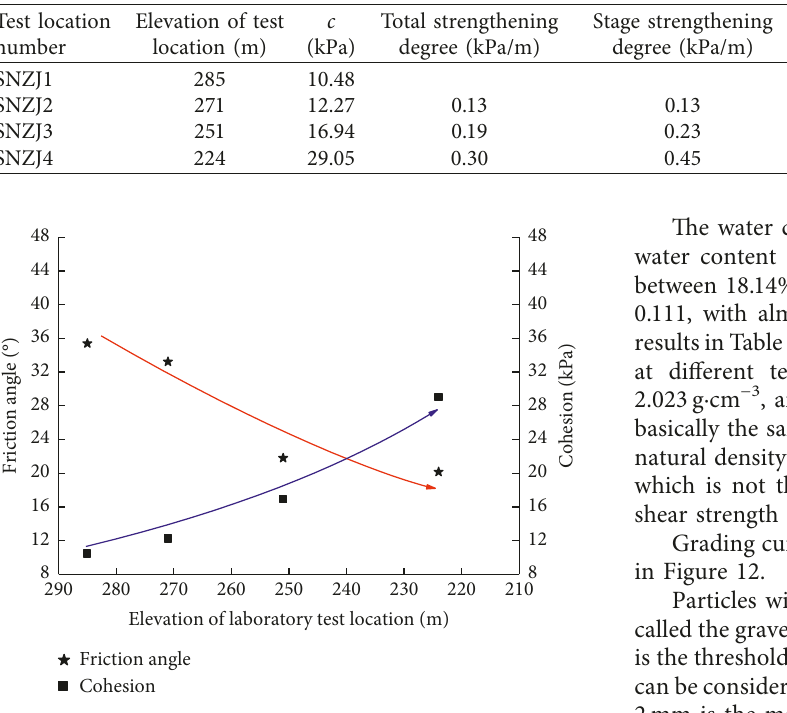
Figure 11: Evolution of shear strength parameters in laboratory direct shear